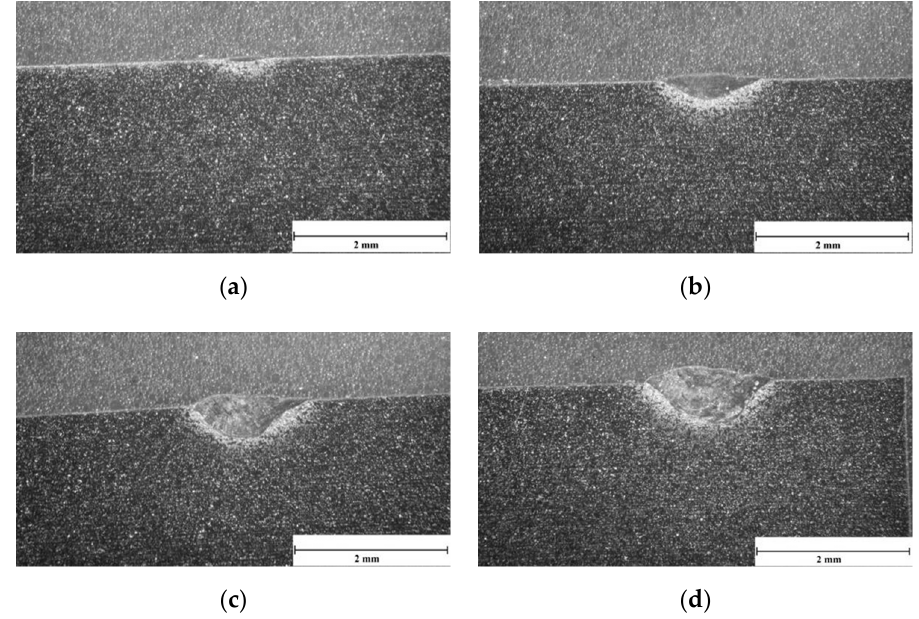
Figure 6. Macrostructure and the single bead geometry of the clad layers produced by laser cladding of Fe-based powder on steel substrate at free cooling, constant scanning speed 1000 mm/min, and different laser output power, as shown in Tables 3 and 4: ( a ) LC13, 250 W; ( b ) LC14, 500 W; ( c ) LC15, 750 W; ( d ) LC16, 1000 W.